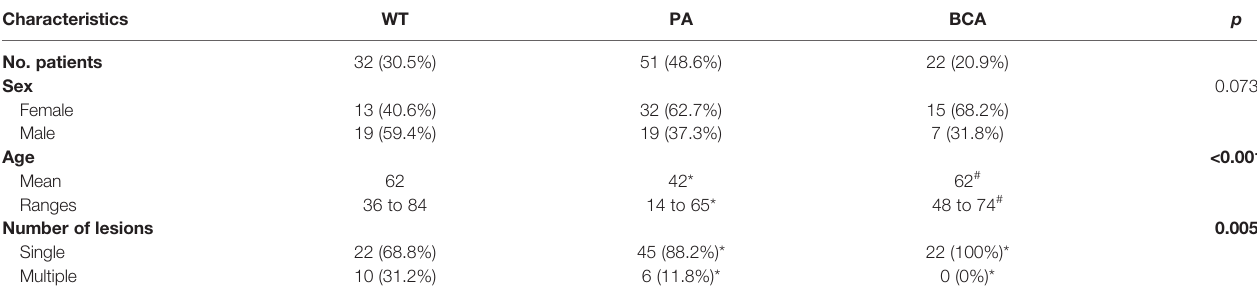
TABLE 1 | Detailed clinical and histopathological characteristics of patients with benign tumors in the parotid gland (n = 105). Characteristics WT PA